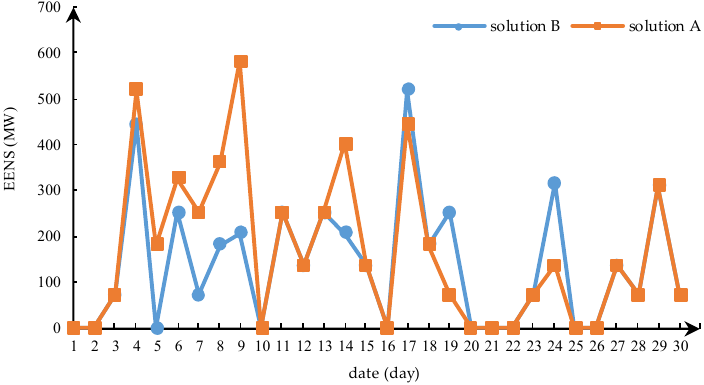
Figure 5. Comparison of system reliability during maintenance period. EENS: expected energy not supplied.